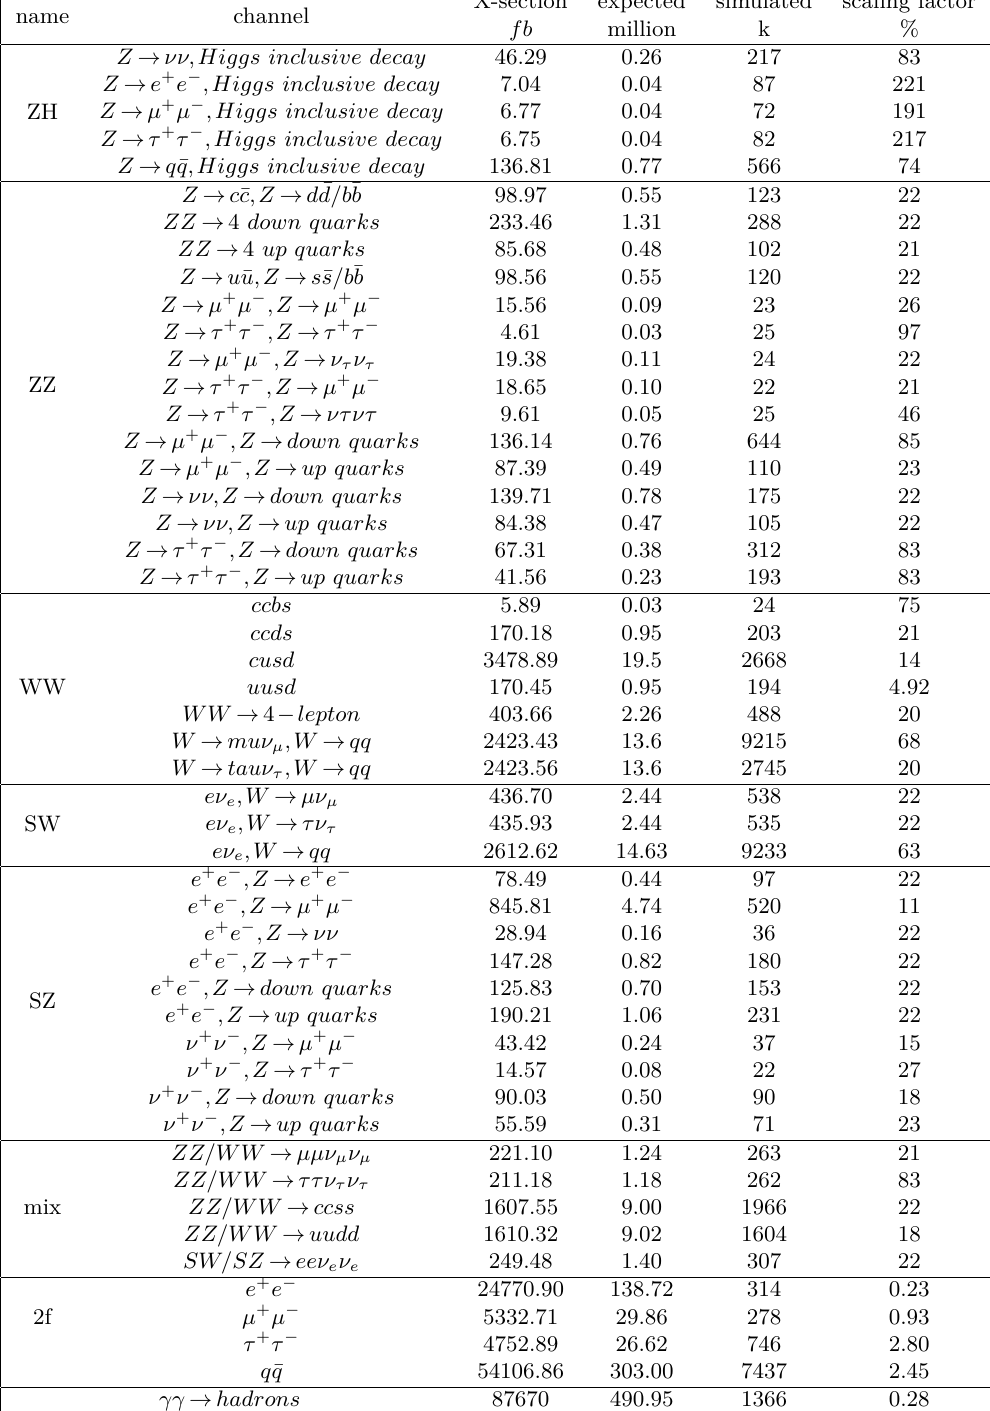
Table 5 . The cross section, expected event number, simulated event number, and scaling factor of the signal and various